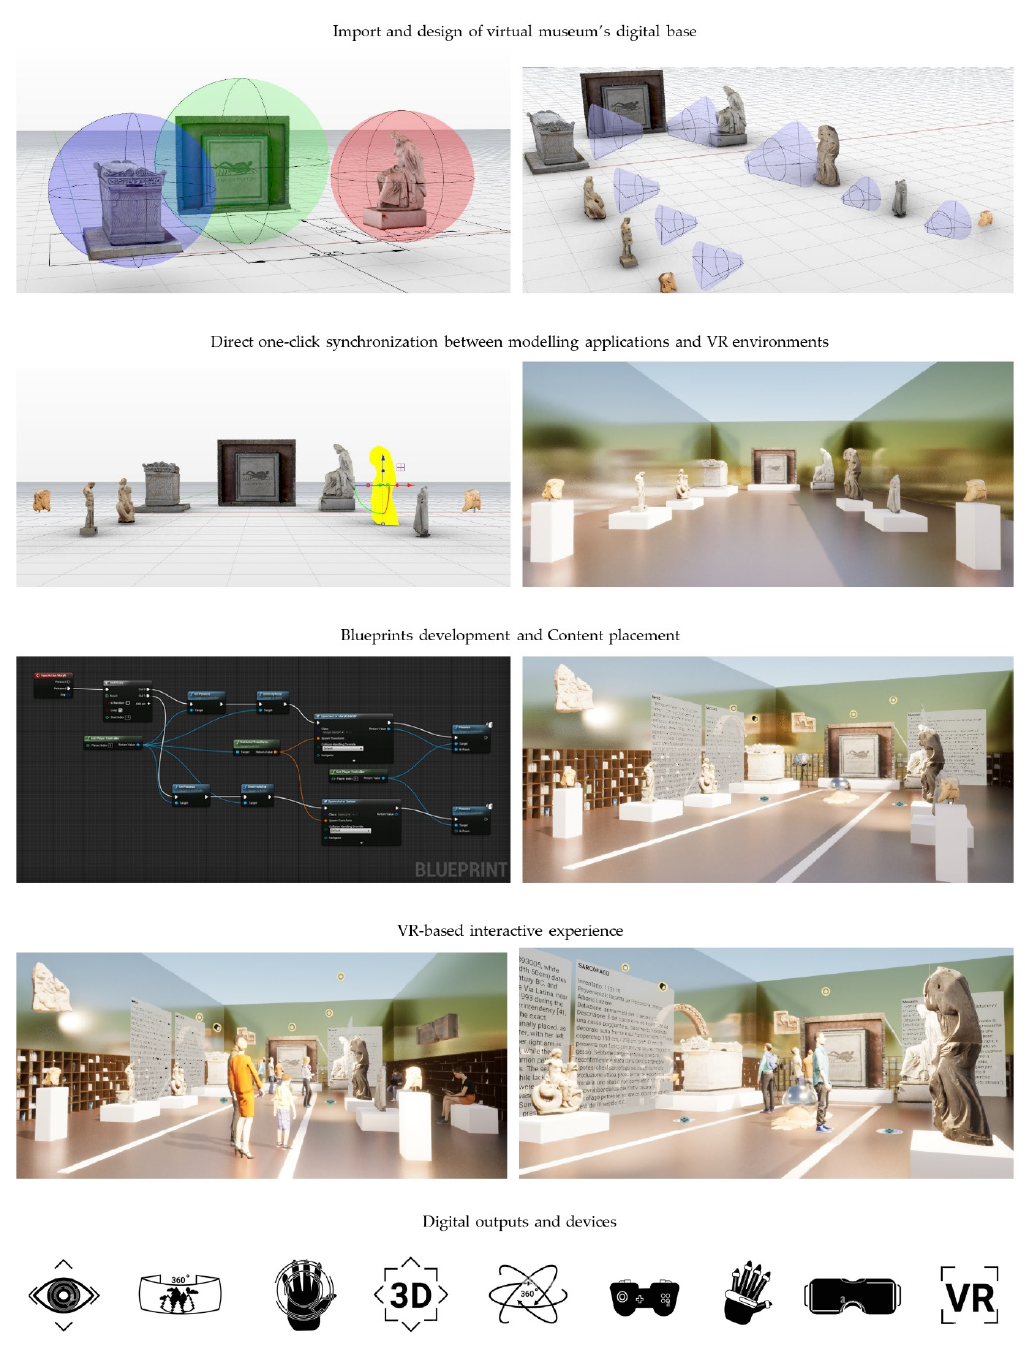
Figure 10. The development process applied to the digital interactive representation of the virtual museum: from textured models to the VR museum: from textured models to the VR headset.